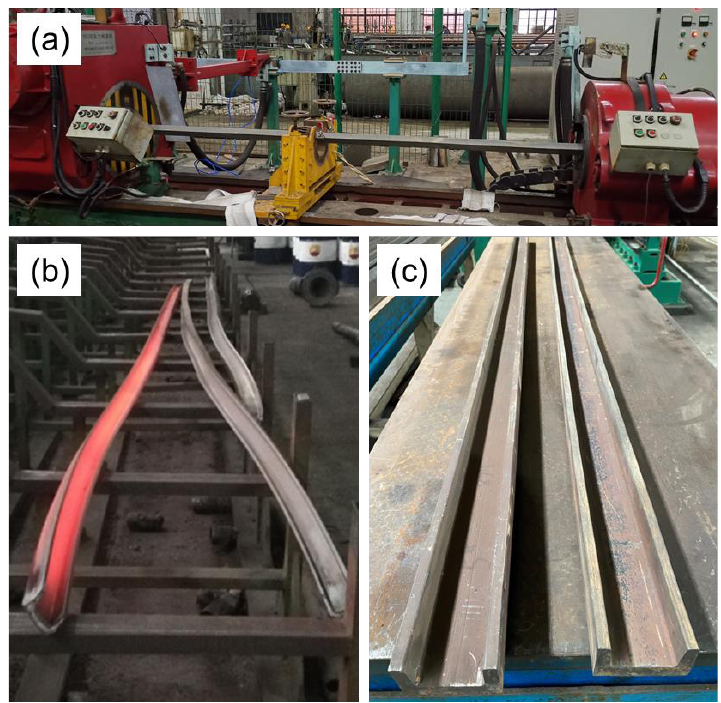
Figure 19. Industry production of the straightening process: ( a ) schematic diagram of straightening; ( b ) profiles before straightening; ( c ) profiles after straightening.